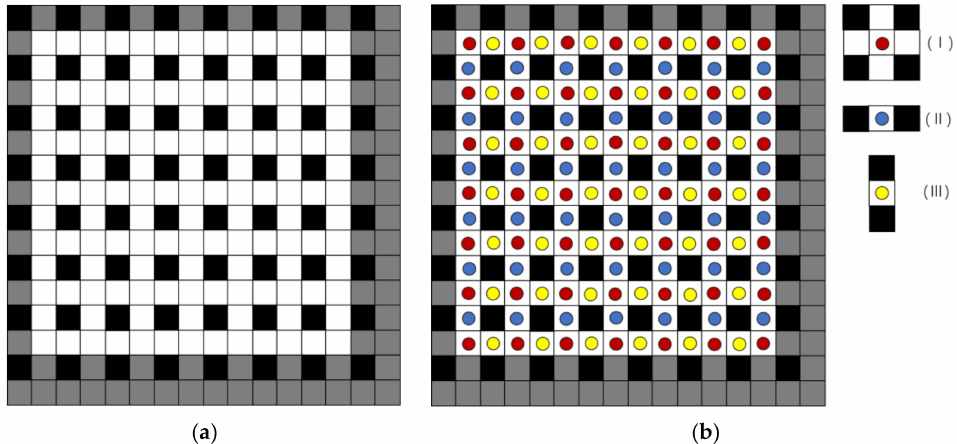
Figure 2. ( a ) The original image is divided into three part: black pixels, white pixels, and grey pixels, ( b ) three types of white